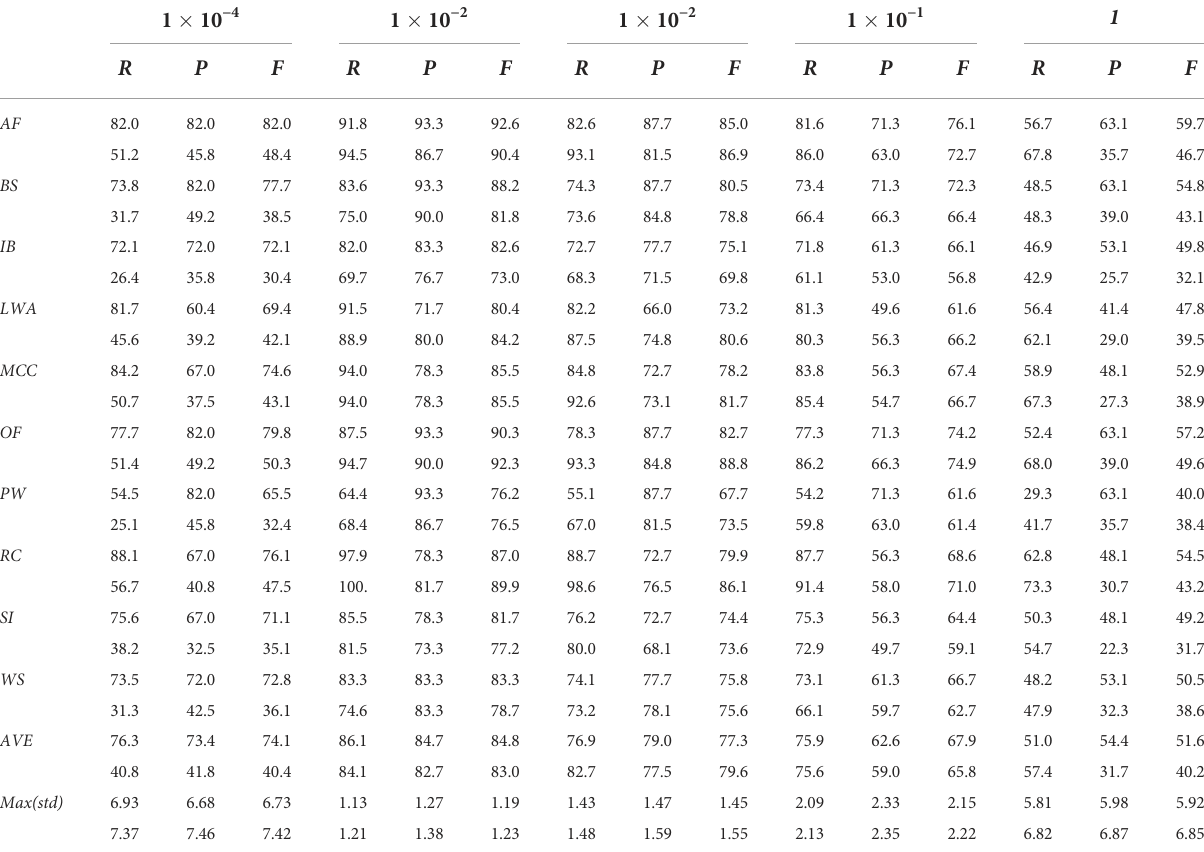
TABLE 4 Classi fi cation performance (%) in WV1 (upper) and WV2 (lower) imagette recognition of KECANet equipped with different width coef fi